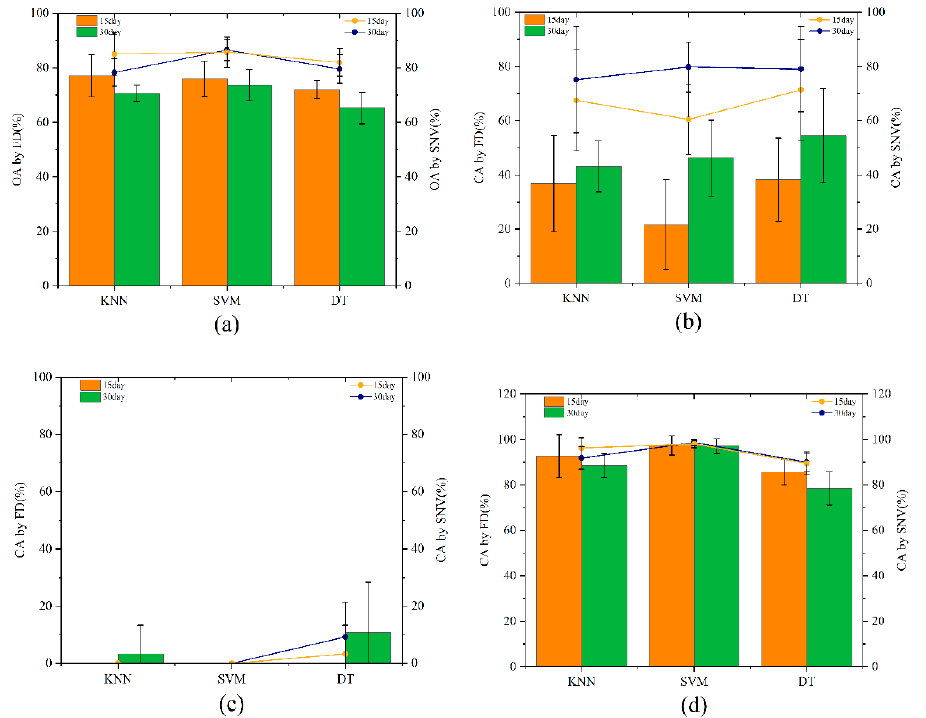
Figure 3. OA ( a ) and CA ( b – d ) modeled based on